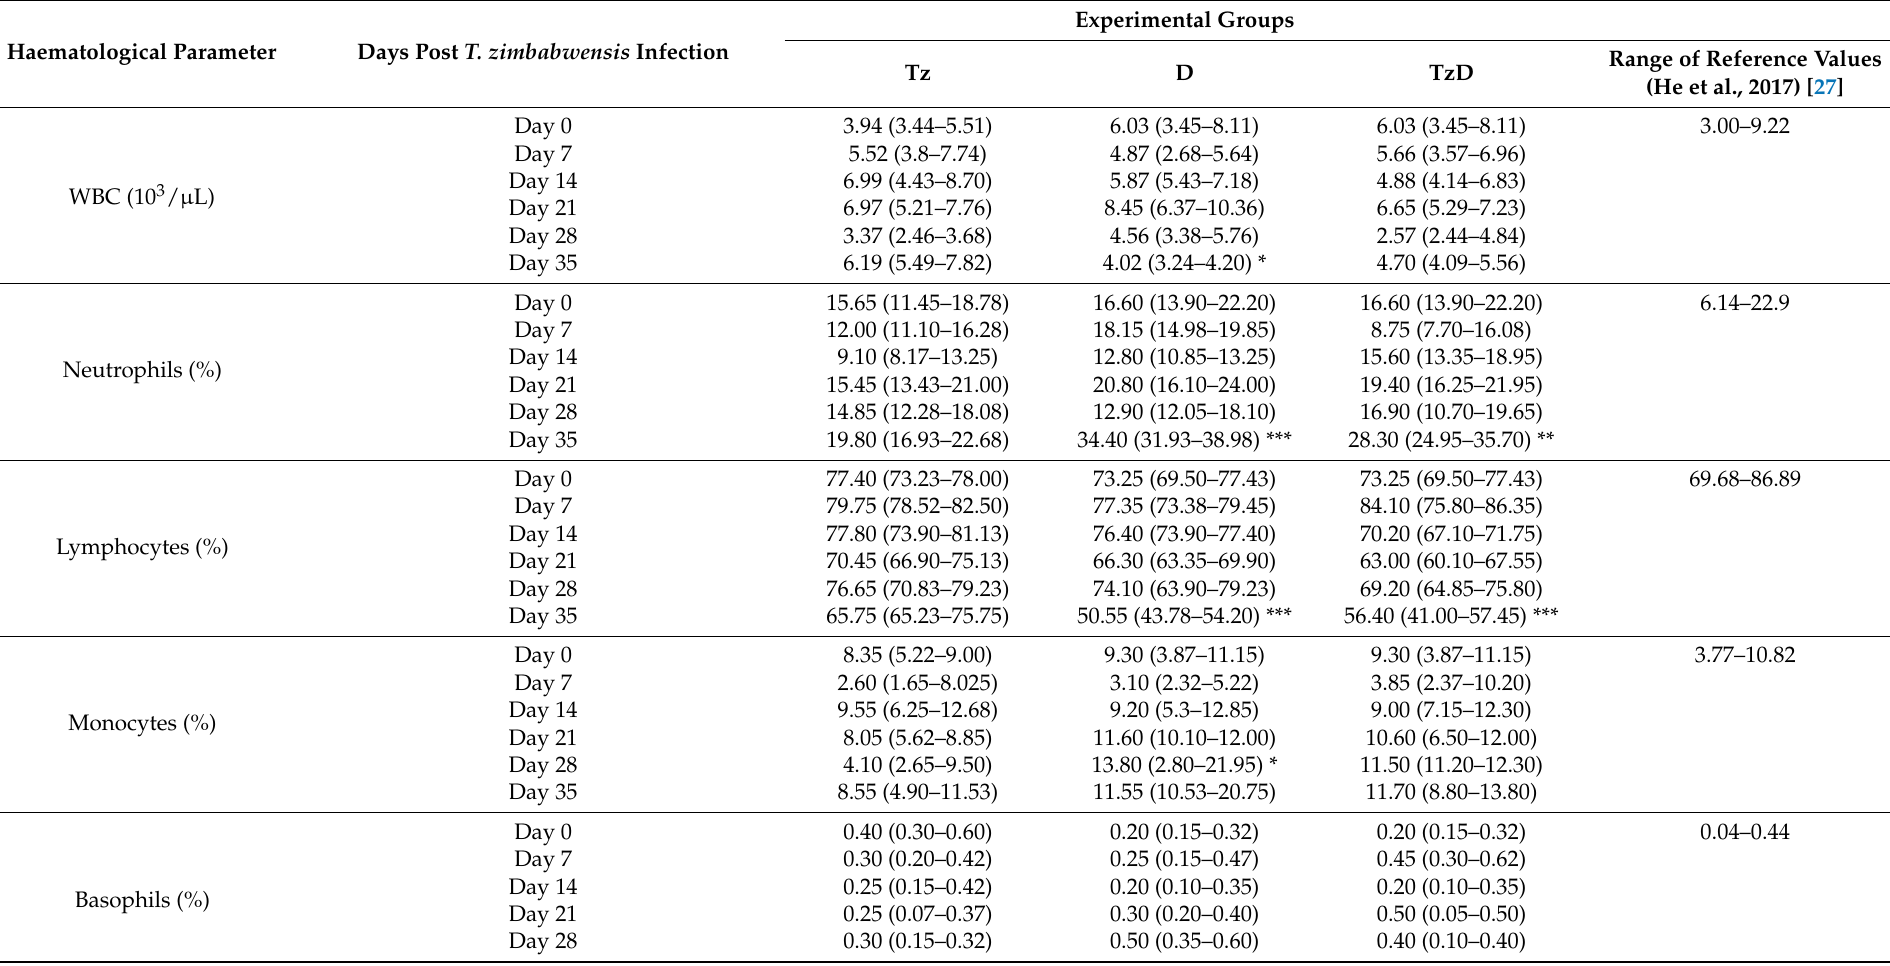
Table 3. Median values (25–75% quartiles) of white blood cells concentration and differentials in Sprague Dawley rats infected with Trichinella zimbabwensis (Tz), with induced type 2 diabetes (D) and co-morbid with T. zimbabwensis and type 2 diabetes (TzD). Day 0 represents the day of Tz infection to diabetic rats with Tz 1st stage larvae from muscles. n = 6 for each group. Values with asterisks represent significant differences between the experimental groups are significantly different (* p < 0.05, ** p < 0.01, *** p <